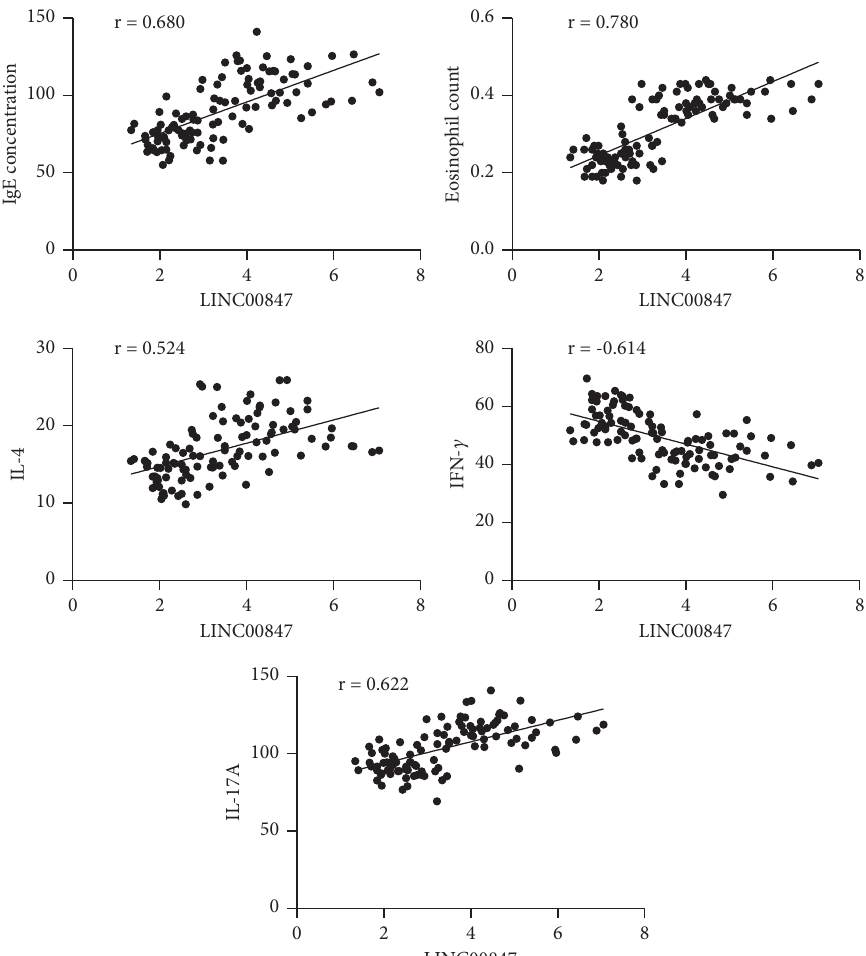
Figure 4: Pearson correlation analysis of the expression level of LINC00847 with IgE concentration, eosinophil count, IL-4, IFN- c , and IL- 17A of asthma children.